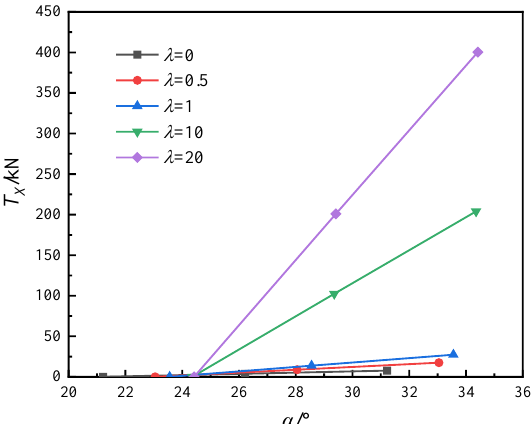
Figure 9. Relationship between force T X between supports and limit angle α .